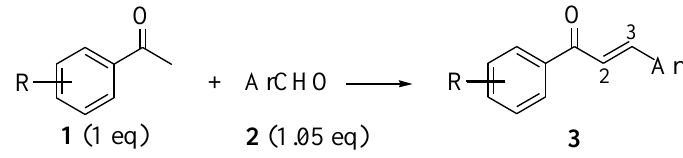
Table 2. Comparison of yield using different reagents and δ of olefinic protons in 3a – o .